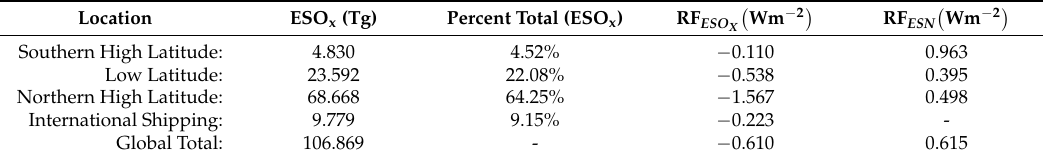
Table 1. Anthropogenic sulfur emissions from the beginning of the century (ESO x ), calculated man-made radiative forcings for the year 2000 (RF ESOx ), and extracted natural radiative forcings for the year 2100 (RF ESN )